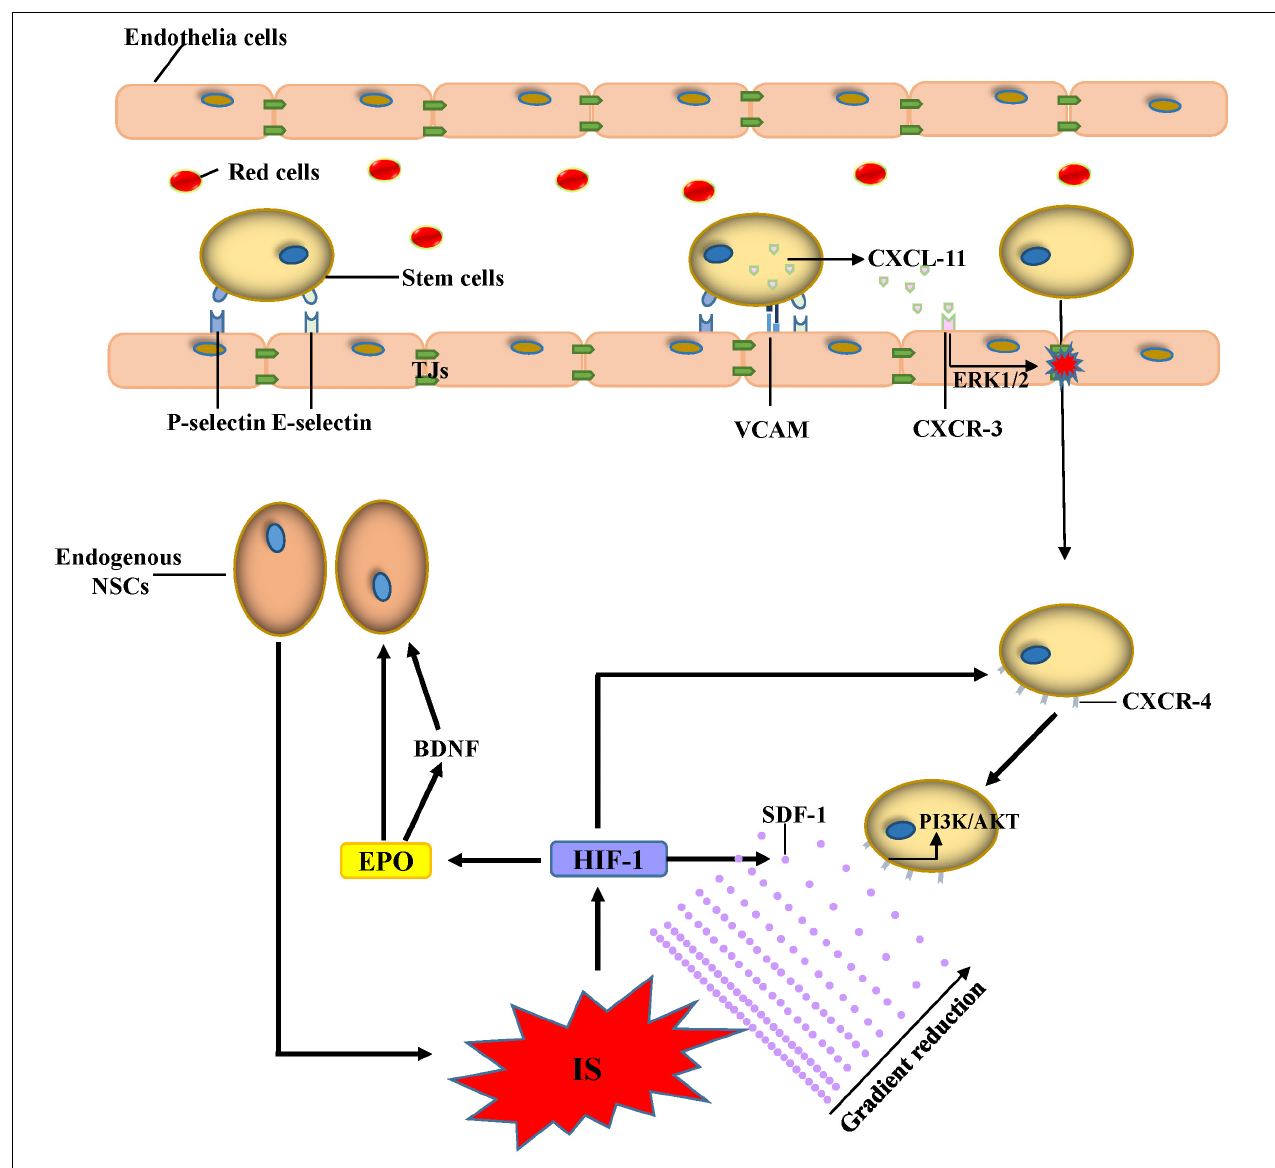
FIGURE 1 | Mechanisms of stem cell migration. Adhesion between stem cells and endothelial cells increases after IS due to the increased expression of E-selectin, P-selectin, and VACM. CXCL-11 released from stem cells can bind CXCR-3 and increase the permeability of the BBB by opening the TJs under the activation of the ERK1/2 signaling pathway. Administered stem cells can migrate to the ischemic lesion by the gradient of SDF-1 through the activation of the PI3K/AKT signaling pathway. The proliferation and migration of endogenous NSCs increase due to BDNF and EPO after IS. Abbreviations: IS, ischemic stroke; VCAM, vascular cell adhesion molecule; CXCL, C-X-C motif ligand; CXCR, C-X-C motif chemokine receptor; EPO, erythropoietin; HIF, hypoxia-inducible factor; SDF, stromal cell-derived factor; PI3K, phosphoinositide-3-kinase; NSCs, neural stem cells; TJs, tight